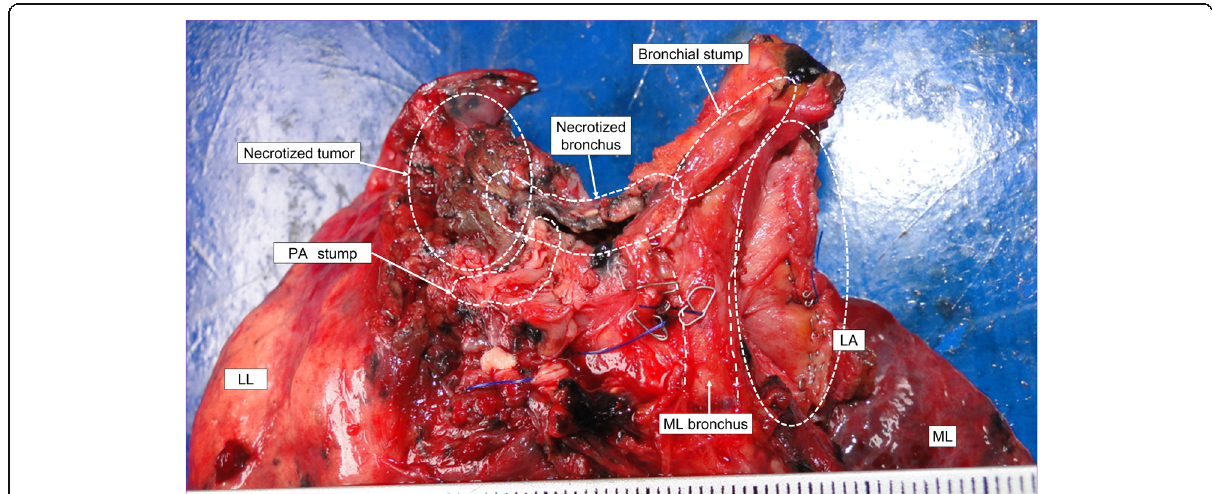
Fig. 3 Resected specimen. The bronchial stump can be observed close to the necrotized bronchi. LN, lymph node; PA, pulmonary artery; ML, middle lobe; LL, left lower lobe; LA, left